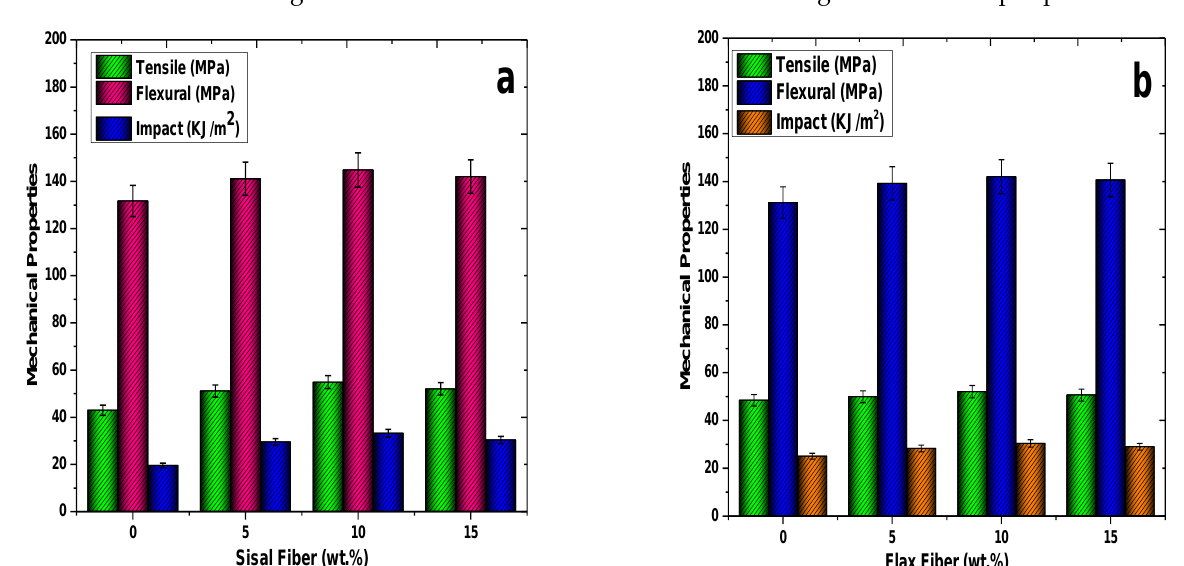
Figure 8. Average value of Mechanical Properties ( a ) wt.% of Sisal Fibre; ( b ) wt.% of Flax Fibre.